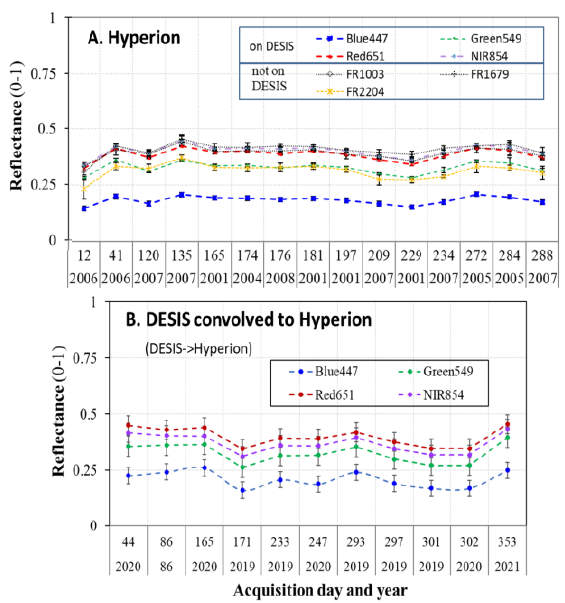
Figure 2. Temporal variation in the reflectance at the RRVP, for select bands: A. Hyperion VSWIR 10 nm reflectance, and B. DESIS VNIR 2.5 nm reflectance convolved to Hyperion 10 nm resolution (DESIS→Hyperion) (means, ±SD, n=15).